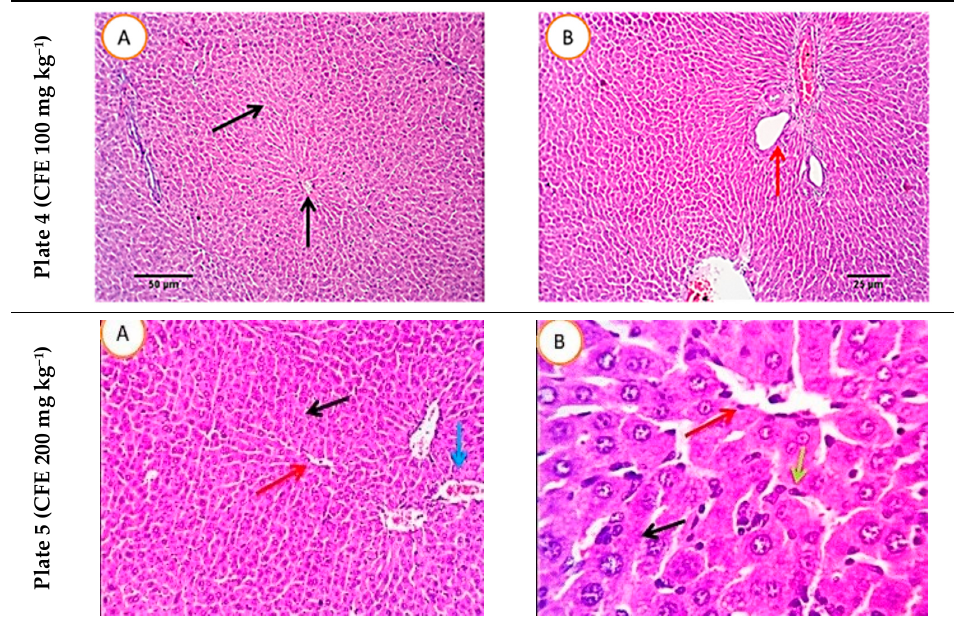
Figure 7. Histopathological photomicrographs of liver tissue (H&E × 100 and 400; A and B ) at the end of the experiment. Plate 1: Negative control, Plate 2: Positive control, Plate 3, rats receiving high-fat diet and treated simultaneously with 10 mg kg − 1 atorvastatin (ATOR), Plates 4 and 5: rats receiving high-fat diet and treated with Lactobacillus paracasei postbiotic (CFE-1 and CFE-2; at 100 and 200 mg kg − 1 , respectively). Postbiotic is the cell-free extract (CFE). The blue arrows refer to hydropic degeneration. Yellow arrows indicate macro- and micro-steatosis in a variable number of hepatocytes. The red arrows refer to moderate lympho-plasmocytic inflammatory reaction in the portal triads and the black arrows mark mild biliary proliferation.